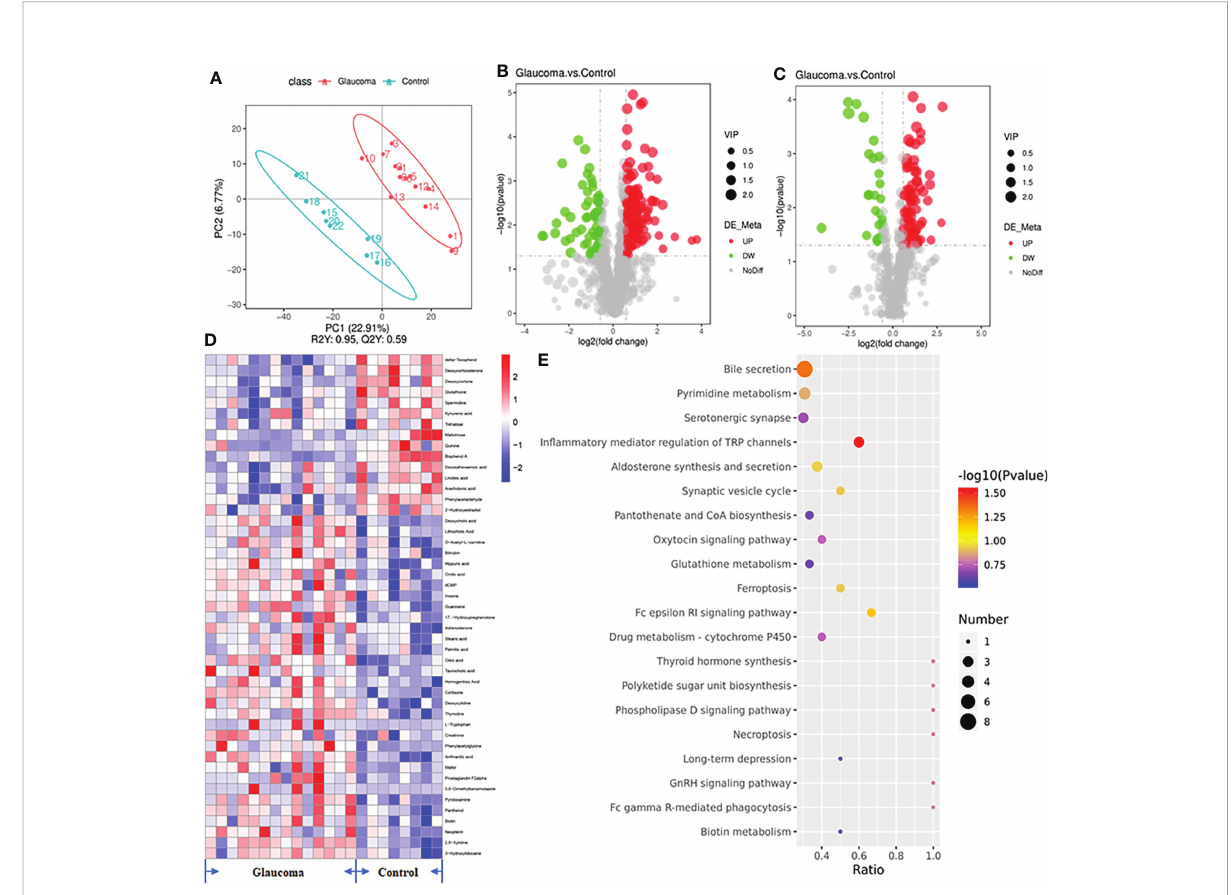
FIGURE 4 Untargeted metabolomics of the microbiota-derived metabolome. (A) The clustering analyses of partial least-squares discriminant analysis (PLS- DA). (B) The volcano plot of differential metabolites in positive polarity mode. (C) The volcano plot of differential metabolites in negative polarity mode. Grey circle represents a nonsigni fi cant difference, red circle represents an upregulation in metabolites, and green represents a downregulation in metabolites. (D) Heatmap of the 47 signi fi cantly different metabolites involved in KEGG pathways across glaucomatous and control rats. (E) Diagram of the KEGG pathways (top 20). The size of the points represents the number of differential metabolites in the pathway, and the color of the point represents the P value of the hypergeometric test. KEGG, Kyoto Encyclopedia of Genes and